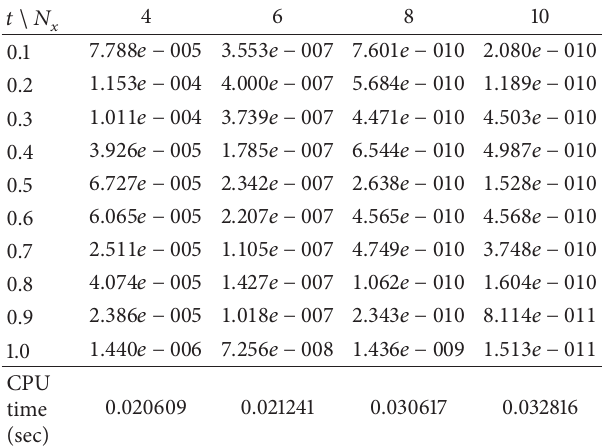
Table 4: Maximum errors 𝐸 𝑁 for the Burger-Huxley equation when = 10 . 𝛾 = 0.75 , 𝛽 = 1 , and 𝑁 𝑡